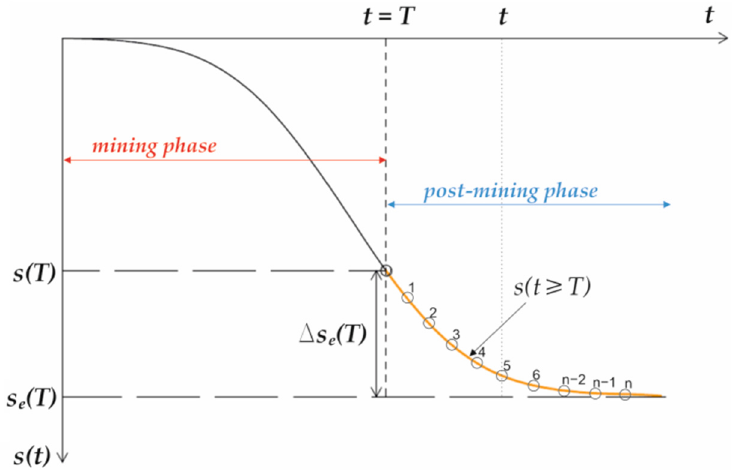
Figure 2. The course of subsidence after the end of mining exploitation—illustration for Formula